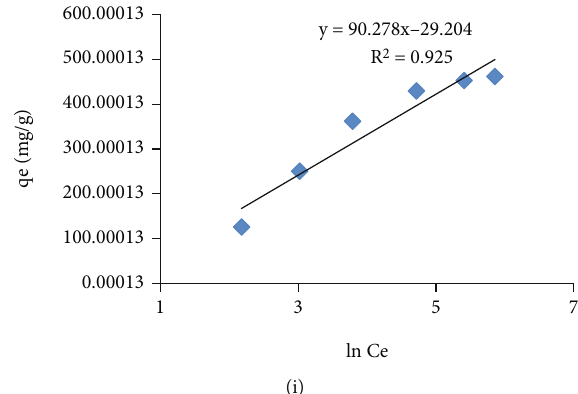
Figure 10: Adsorption isotherms for the toluidine adsorption on the GA/AM (adsorbent 0.01g, dye solution 10 mL, time 60min, pH11, temp 293, 313, 333 K). Langmuir isotherm at (a) 293K, (b) 313 K, and (c) 333K; Freundlich isotherm at (d) 293K, (e) 313 K, and (f) 333K; and Temkin isotherm at (g) 293K, (h) 313K, and (i) 333 K.